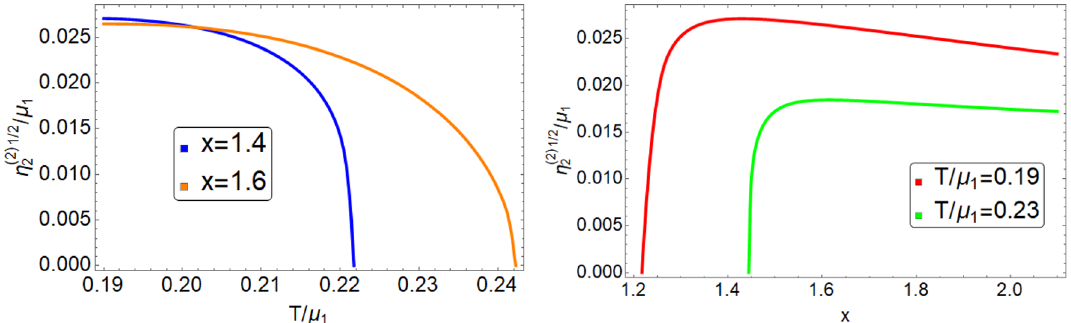
Figure 13 . The PDW order parameter η (2) parameter